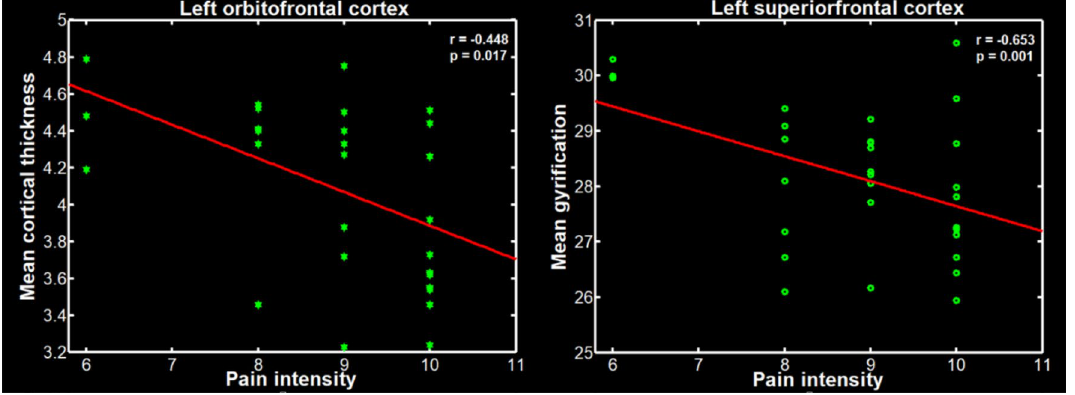
Figure 3. Scatter plots of the mean gyrification of the left superior frontal cortex, and the mean cortical thickness of the left orbitofrontal cortex negatively correlated with the pain intensity in the trigeminal neuralgia (TN)